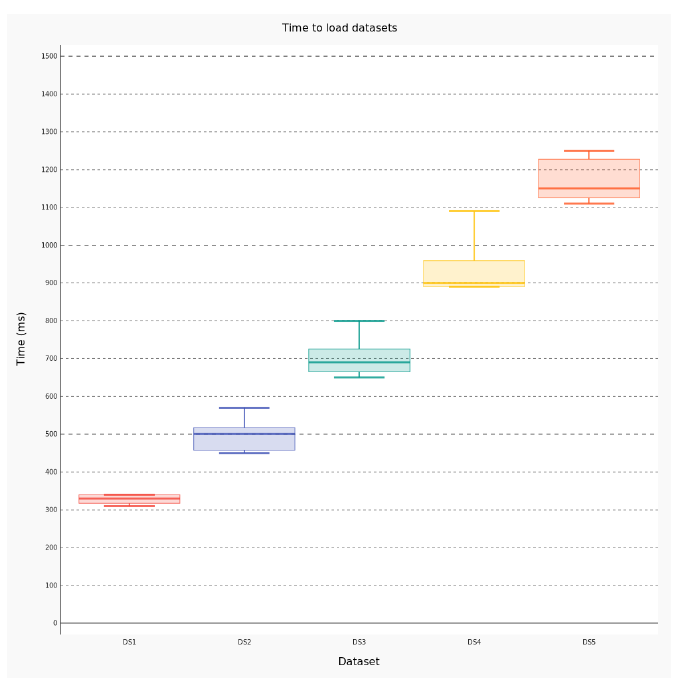
Figure 23. Time employed by the data extractor to analyze data depending on the